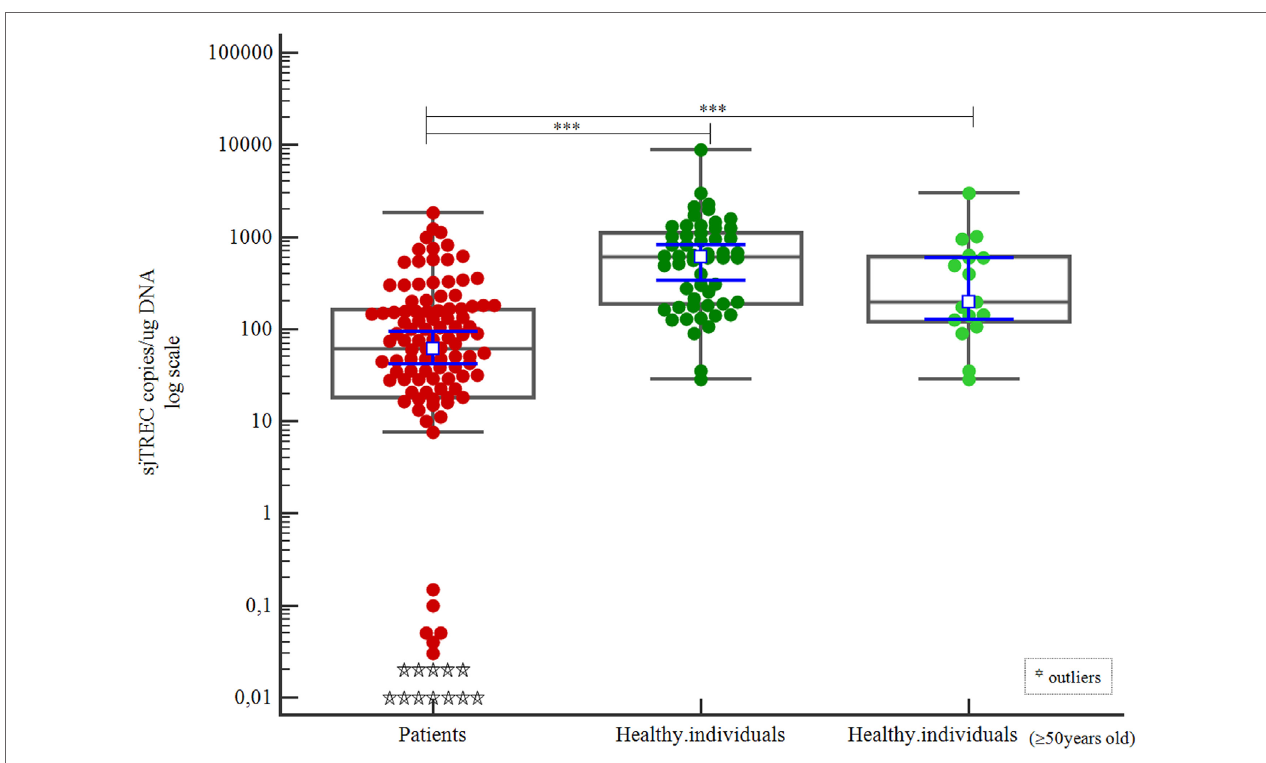
FigUre 4 | Correlation of signal joint TREC (sjTREC) count between patients and healthy individuals.